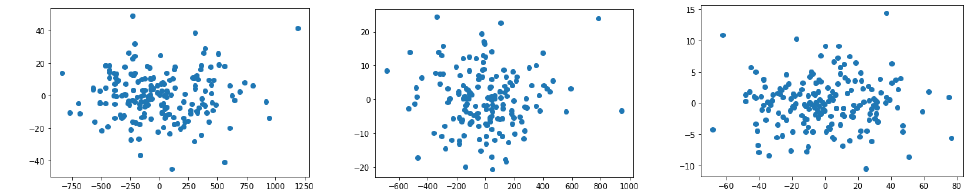
Figure 18. Node embedding of random graph with 5 and 10 relations